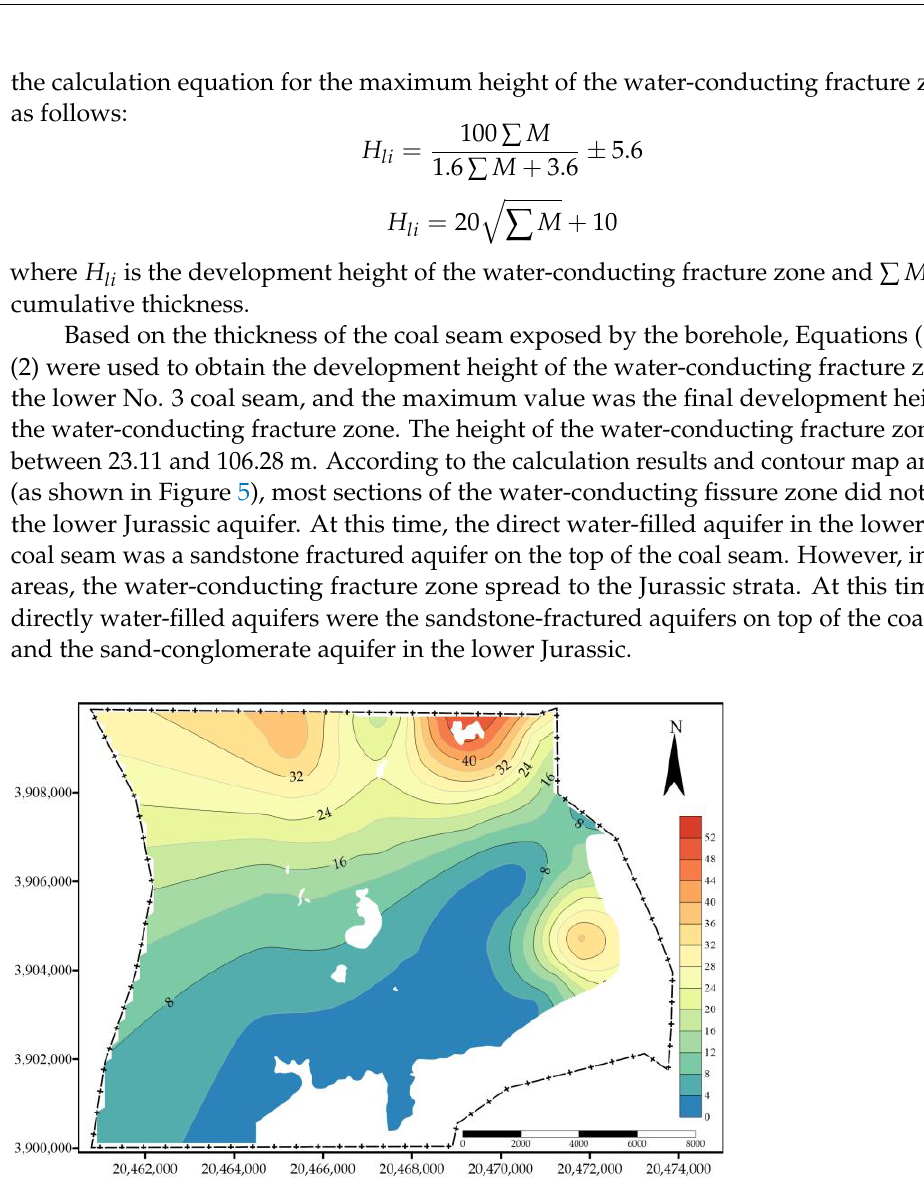
Figure 5. Factors of roof water inrush in development height of water-conducting fracture zone.